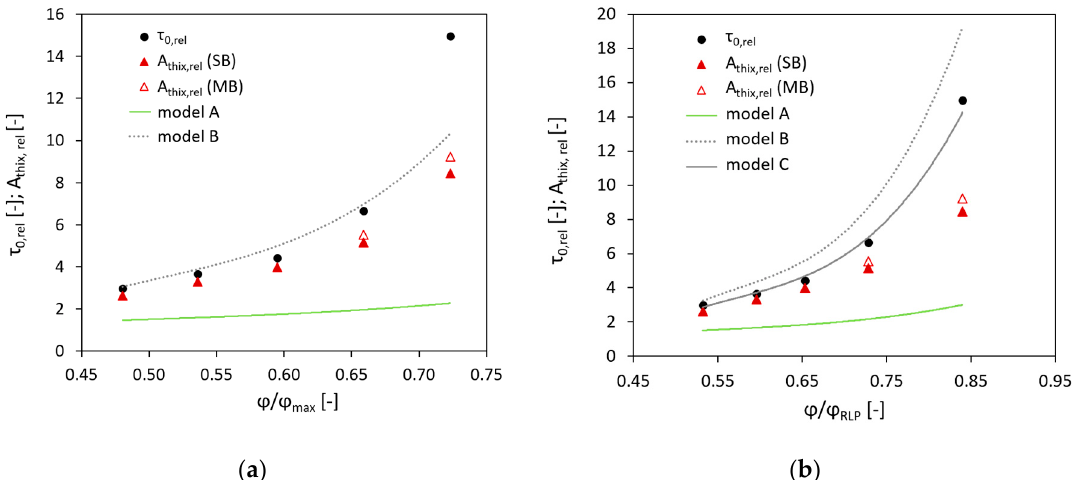
Figure 3. Relative initial SYS and relative structural build-up rate versus relative volume fraction calculated using ( a ) maximum volume fraction and ( b ) random loose packing fraction. Model A is Chateau–Ovarlez–Trung model, [ η ] = 2.5; model B is modified Chateau–Ovarlez–Trung model, [ η ] =